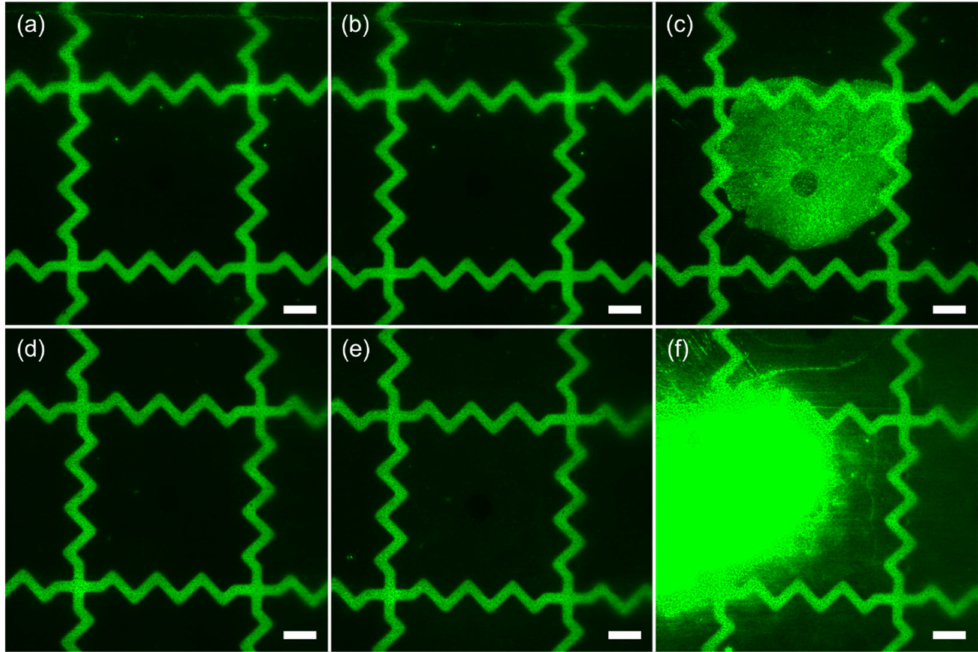
Figure 6. Fluoropor films mounted on the electrodes of the DMF device were examined for the adhesion of biomolecules after actuation by electrowetting by fluorescence microscopy. ( a ) Micro- scopic image of a Fluoropor film before actuation of a 20 µ L droplet of aqueous biomolecule solution. ( b ) After a droplet of Streptavidin-Cy3 was moved ten times over the electrode no staining of the Fluoropor surface was observed. ( c ) For comparison the repellence was broken down with ethanol followed by placing a Streptavidin water droplet on the Fluoropor surface. A clear staining of the surface was observed. Analogously an aqueous solution containing an oligonucleotide was moved ten times over the surface. The Fluoropor surface showed no staining before ( d ) and after ( e ) droplet movement. ( f ) Again, the repellence was broken using ethanol with subsequent immersion of the oligonucleotide droplet resulting in detectable surface staining. As can be seen, Fluoropor does prevent adhesion of biomolecules, as long as the inherent repellence of the material is not prevented. Scale bars: 500 µ